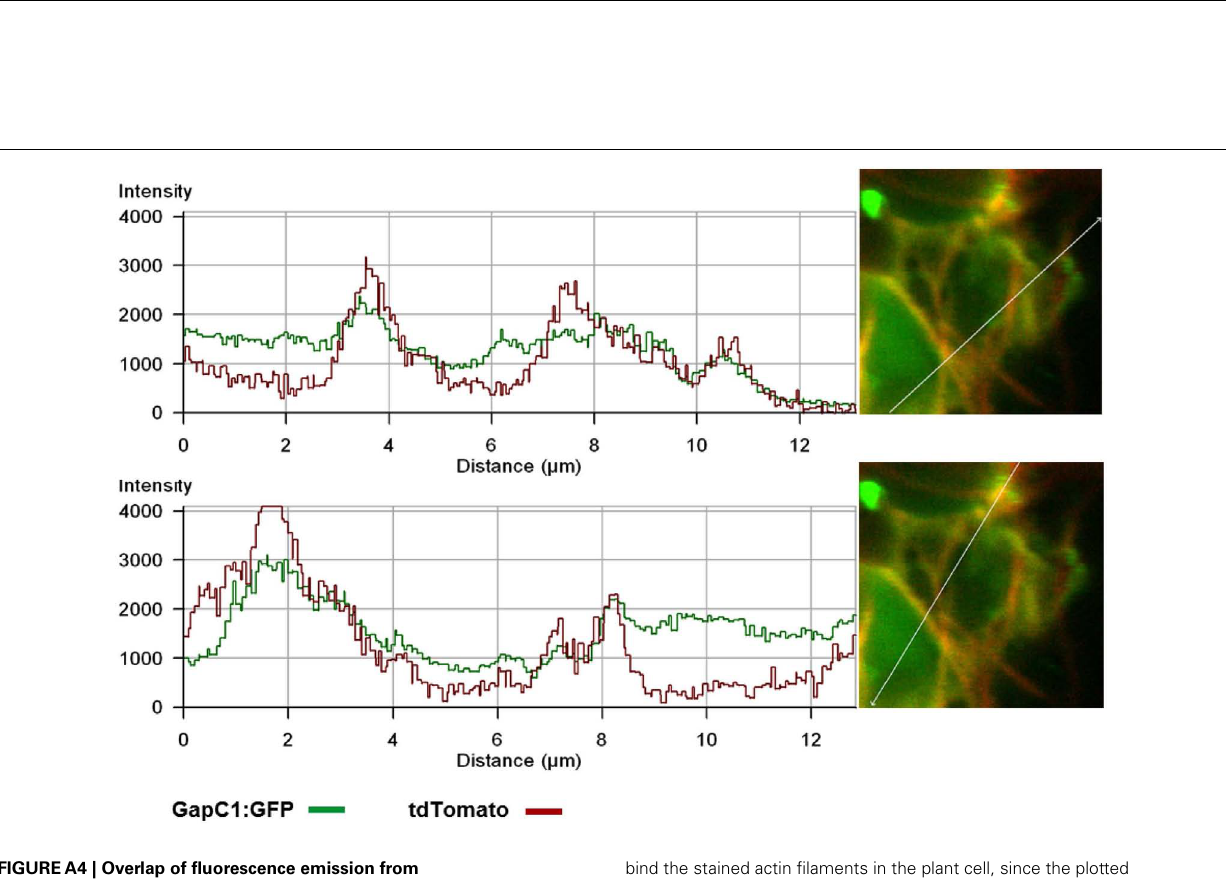
FIGUREA4 | Overlap of fluorescence emission from tdTomato-Fimbrin and GapC-GFP. Fluorescent signals of GapC1:GFP and F-actin, stained with tdTomato:AtFim1-ABD2, were analyzed with the fluorescence-intensity profile.The GapC1:GFP protein seems to